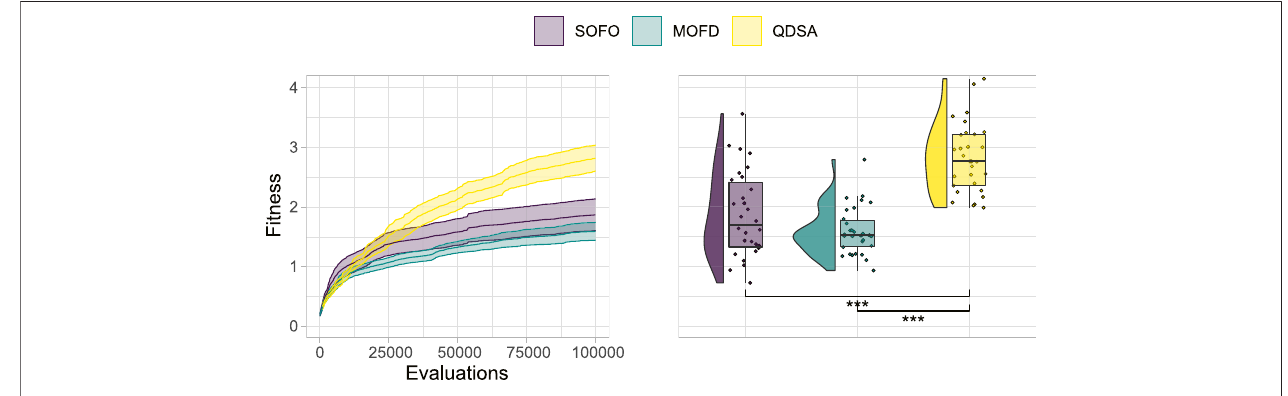
FIGURE4| Fitnessofthesinglebestsolutionfoundinthepopulation.Ontheleftthemeanisshowntogetherwitha95%con fi denceintervalovergenerationaltime. On the right, the best fi tness after the last evaluation for all repetitions is shown. Statistically signi fi cant differences are marked on the right using a Mann-Whitney U test with Holm